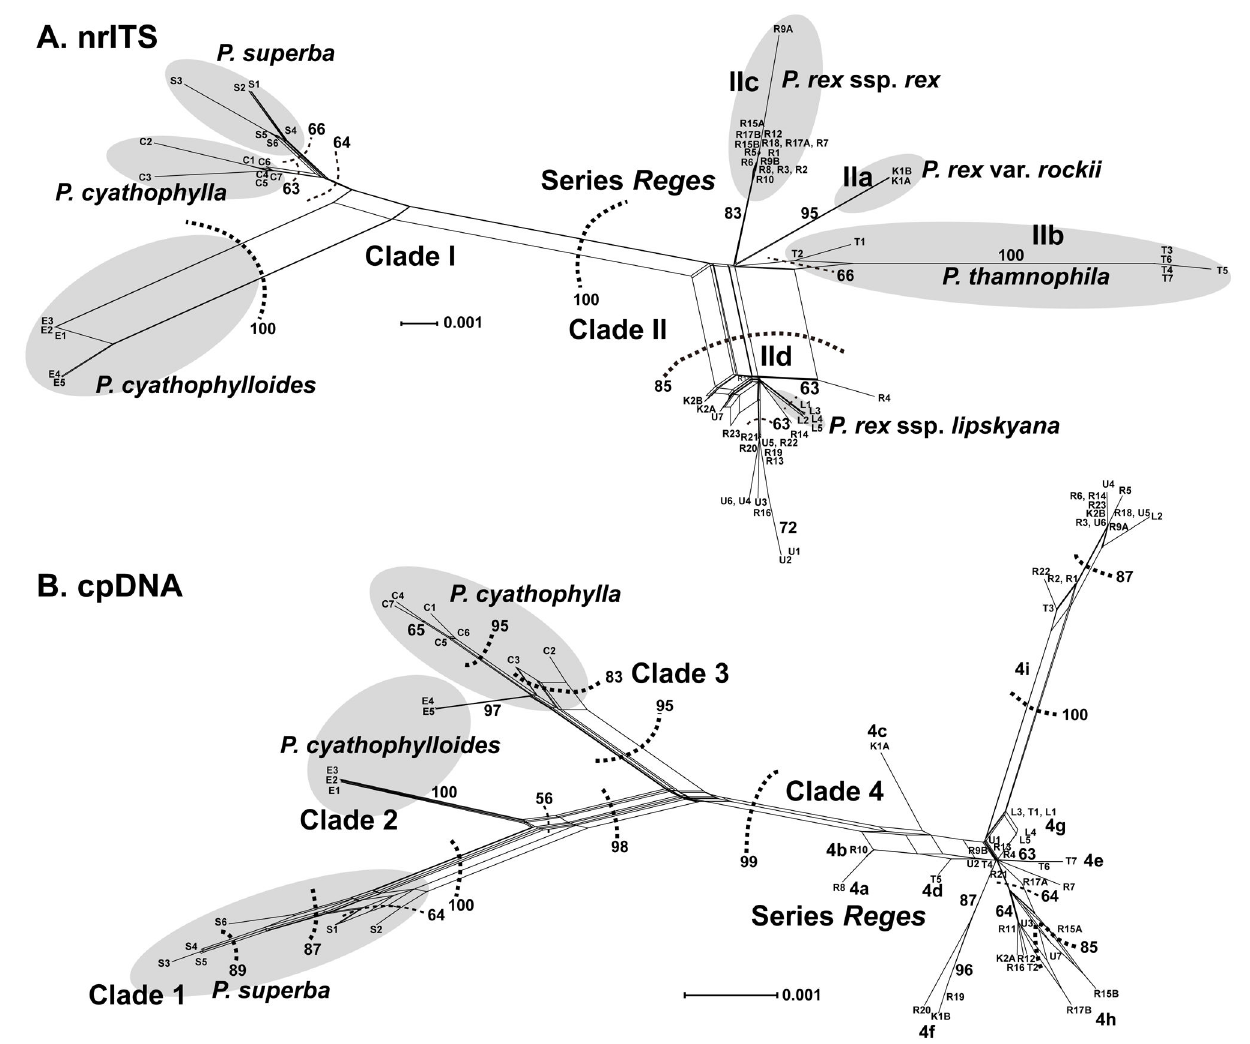
Figure 4. Neighbor-net analysis of Pedicularis section Cyathophora using nrITS (A) and the concatenated chloroplast (B) datasets. Bootstrap support values for clusters are indicated next to the respective cluster delimitation (dashed lines); monophyly of accepted taxa is annotated in gray, except P. cyathophylloides in the chloroplast network. Scale bar indicates changes. doi: